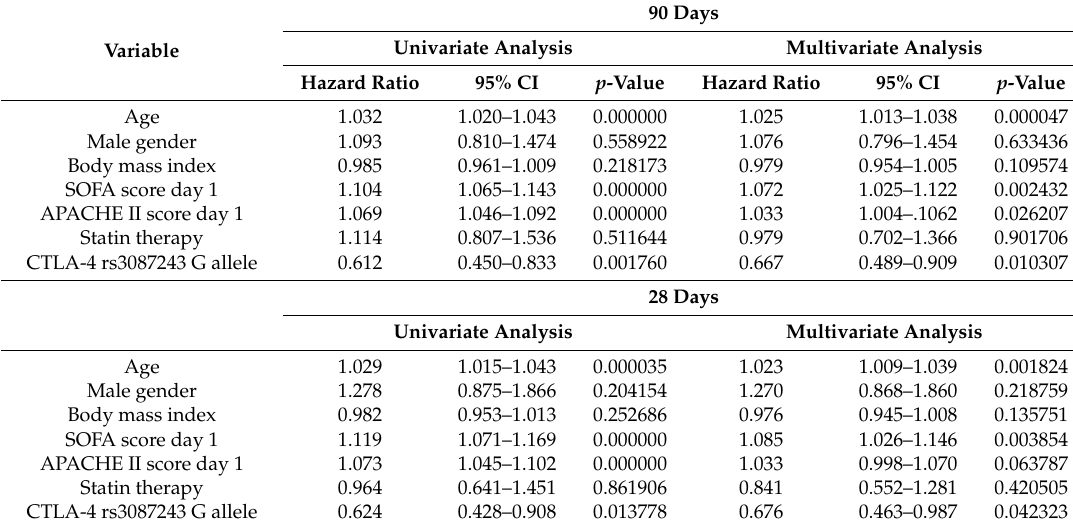
Table 4. Cox regression analysis with regard to the CTLA-4 rs3087243 genotypes.